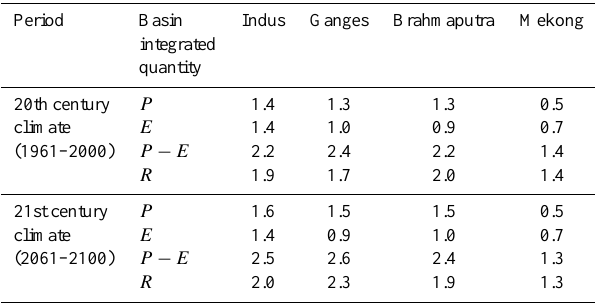
Table 4. Ratio between the ensemble spread and the ensemble mean for the 40yr climatological averages of selected basin-integrated